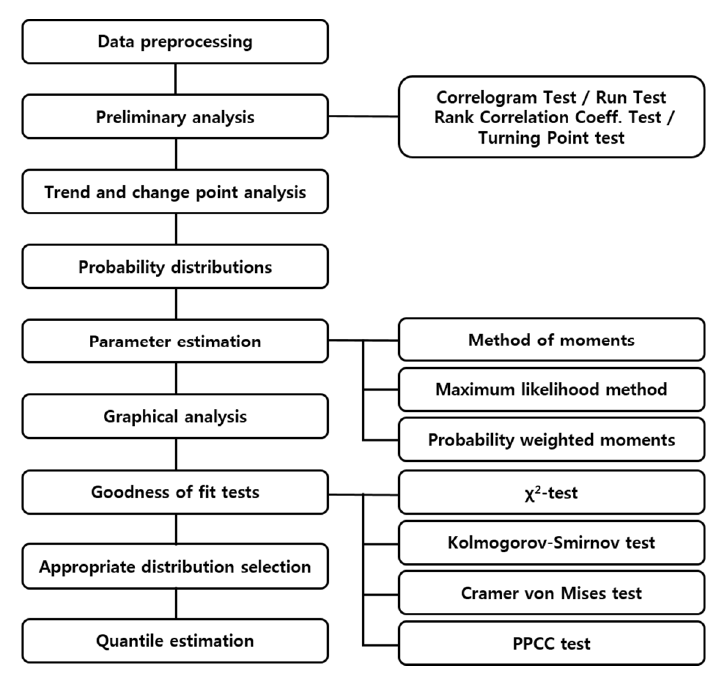
Figure 4. The procedure of frequency analysis in the software FARD [28]. Reproduced with permission from National Disaster Management Institute, FARD User Manual; published by National Disaster Management Institute, 2006. PPCC: Probability plot correlation